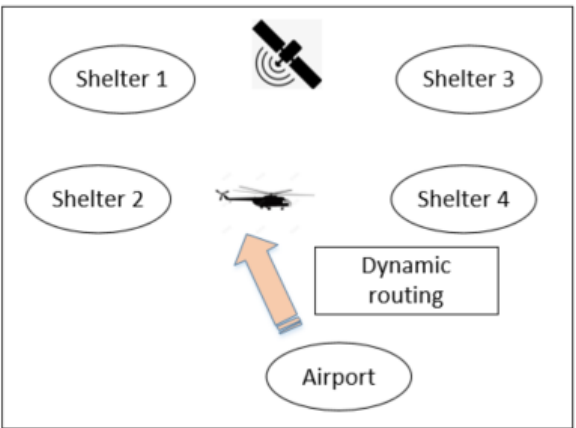
Figure 6. Information flow in Level